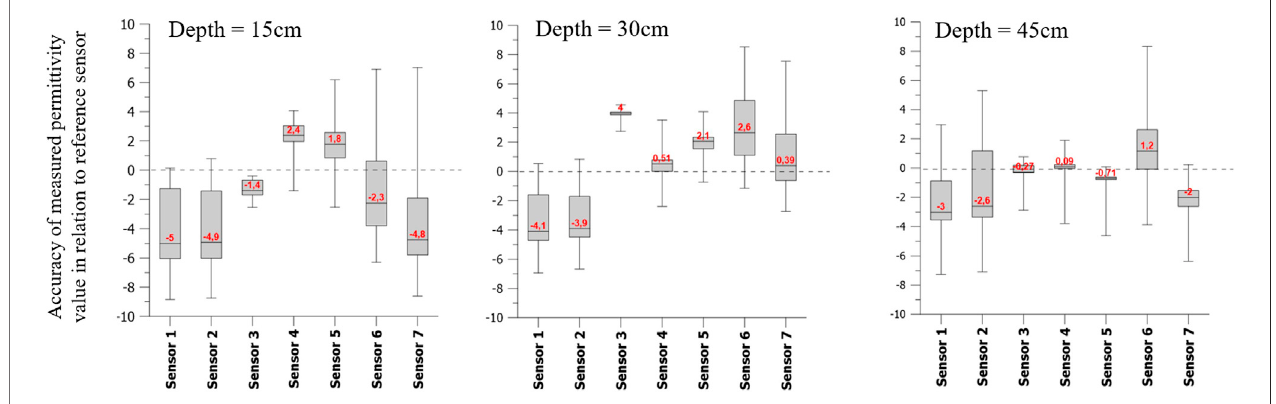
FIGURE5| Differencetoreferencesensorfor3depths(15,30and45 cm),Box-WhiskerPlot(Min,Maximum,Medianvalueinred),dottedlinemedianofdifference at a certain depth.